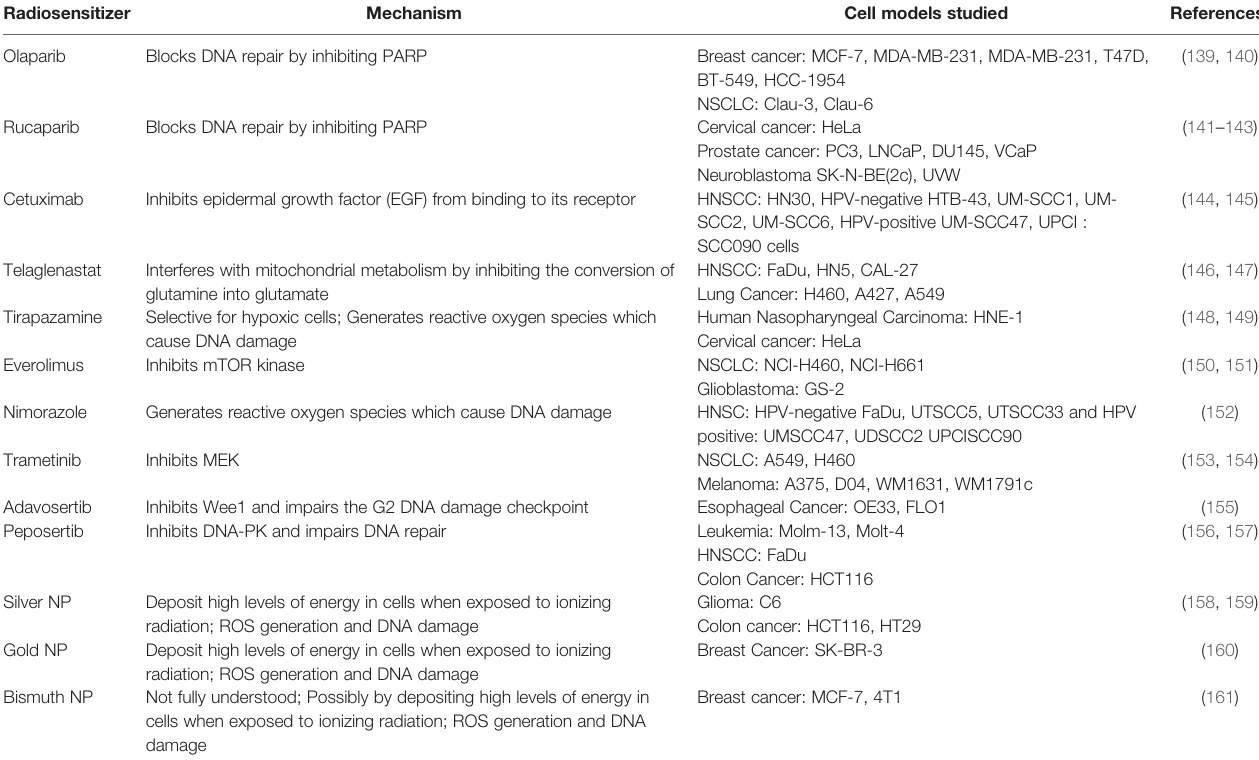
TABLE 1 | List of radiosensitizers, respective mechanism of actions and preclinical models used to study them.